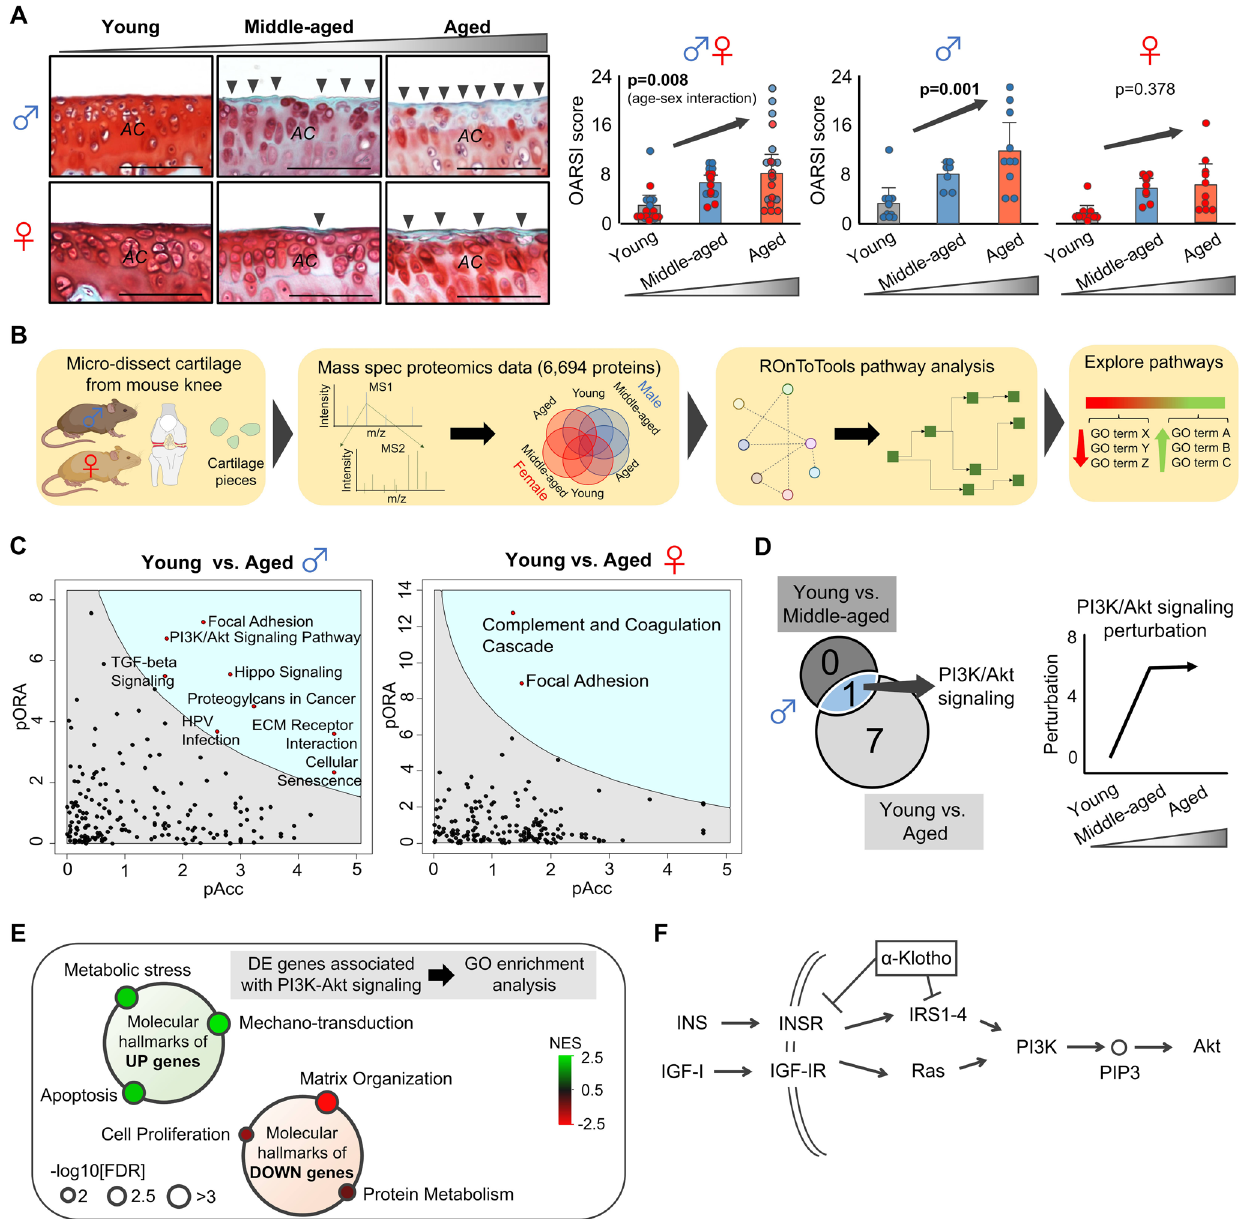
Fig. 1 | Male, but not female, mice display age-related cartilage degeneration anddisruptionofthePI3K-Aktsignalingpathway.A Aginginducedprogressive cartilagedegenerationinmurinemedialtibialplateausinasex-dependentmanner. Representative histological sections stained with Safranin O/Fast Green are pro- vided for each group. Black arrow heads indicate loss of cartilage matrix. The Osteoarthritis Research Society International (OARSI) score is provided (0 – 24 points;highervalueindicatesmoreseverecartilagedegeneration),asassessedbya blinded assessor (male, n =10 for young and aged, n =7 for middle-aged; female, n =10 for young and aged, n =9 for middle-aged). Statistical analyses were per- formed using linear regression. Data are presented as means ± 95% con fi dence intervals. Scale bar: 50 μ m. B Schematic showing the experimental protocol for